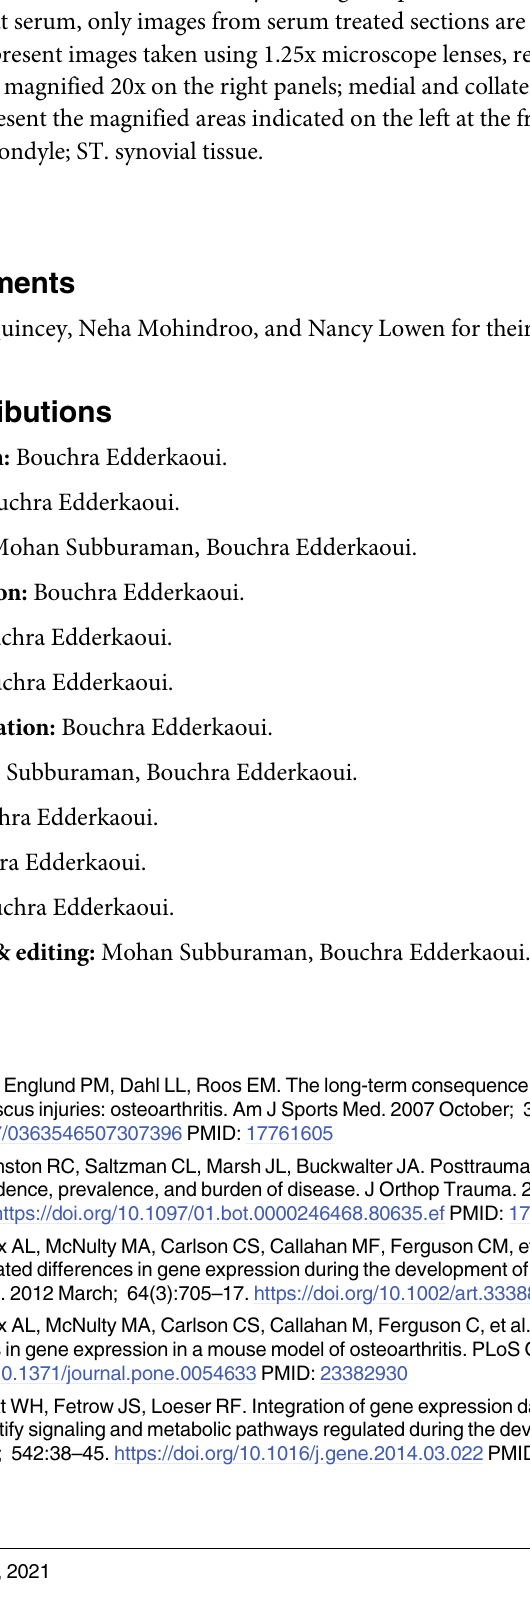
S2 Fig. Images of histology sections from immunohistochemistry staining using normal goat serum as negative control. Histology sections were collected, at day 3 post-surgery, from sham- ( A and D ), MMD-knees treated with PBS ( B and E ) and MMD-knees treated with CCL21-ab ( C and F ). Immunohistochemistry staining was performed using primary antibod- ies and normal goat serum, only images from serum treated sections are presented in this fig- ure. Left panels represent images taken using 1.25x microscope lenses, red and blue squares represent the areas magnified 20x on the right panels; medial and collateral. The images in green squares represent the magnified areas indicated on the left at the frontal side of the joint capsule. F. femur condyle; ST. synovial